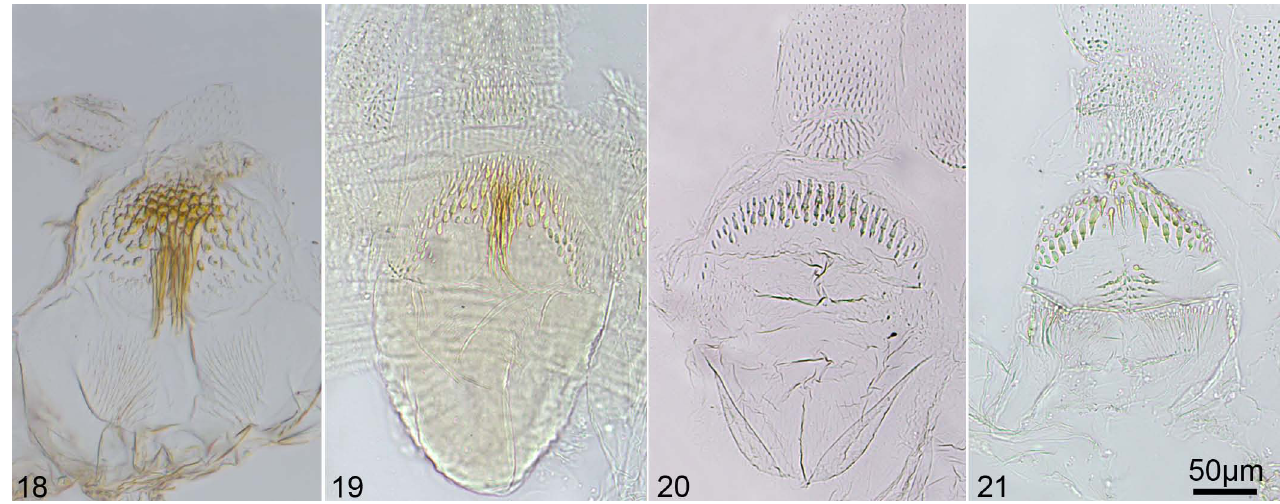
Figs 18–21. Enteric valve armature of: 18- Heterotermes tenuis ; 19- Coptotermes testaceus ; 20- Prorhinotermes oceanicus and 21- Rhinotermes marginalis